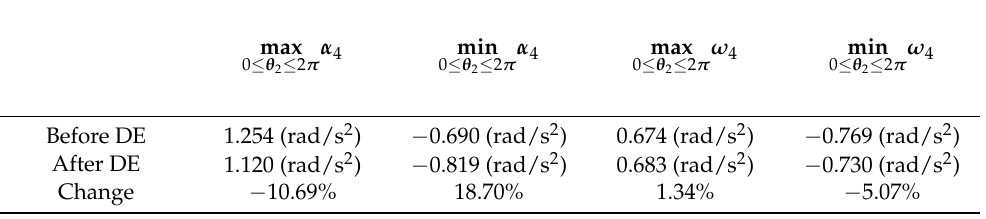
Table 4. α 4 and ω 4 of the driver side output-link of CDLS before/after DE optimization.